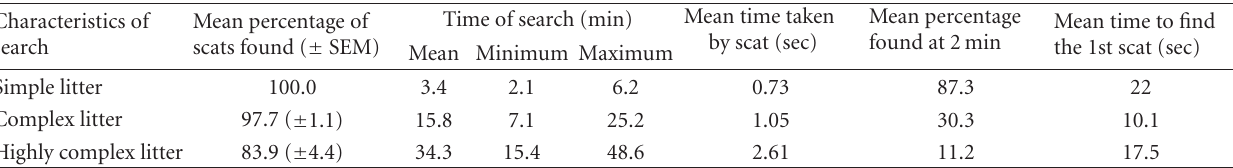
Table 3: Percentage of scats detected and time needed to detect them, in three di ff erent ground layer complexities. Characteristics of